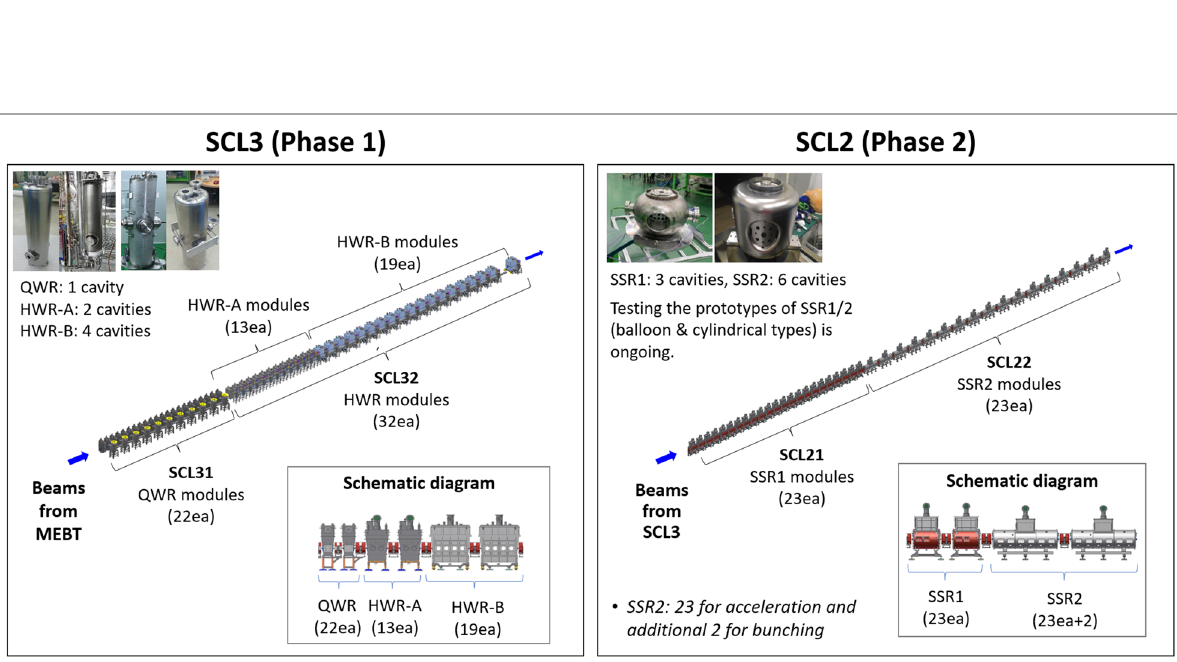
Fig. 4 Overview of the superconducting linac systems. The left panel shows the SCL3 system that is completed in Phase 1, and the right panel shows the SCL2 system that is under development as Phase